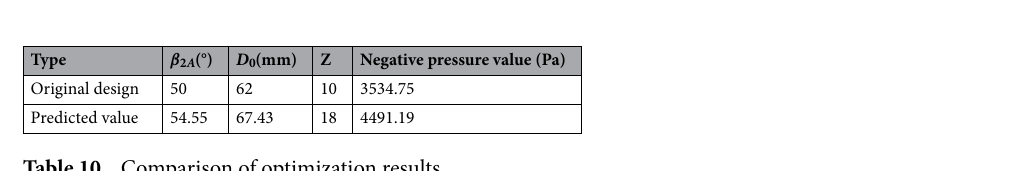
Table 10. Comparison of optimization